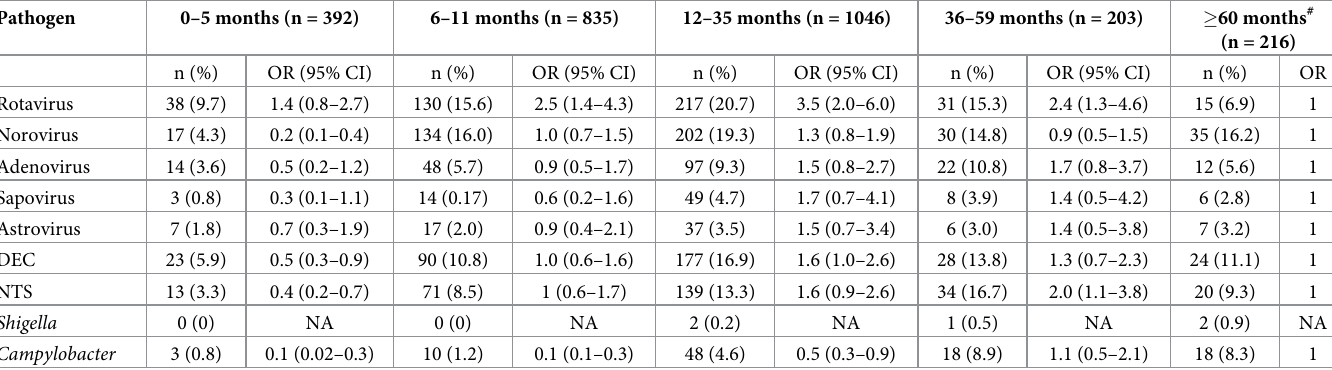
Table 3. Age-specific prevalence of enteropathogens in children with acute diarrhoea. Pathogen